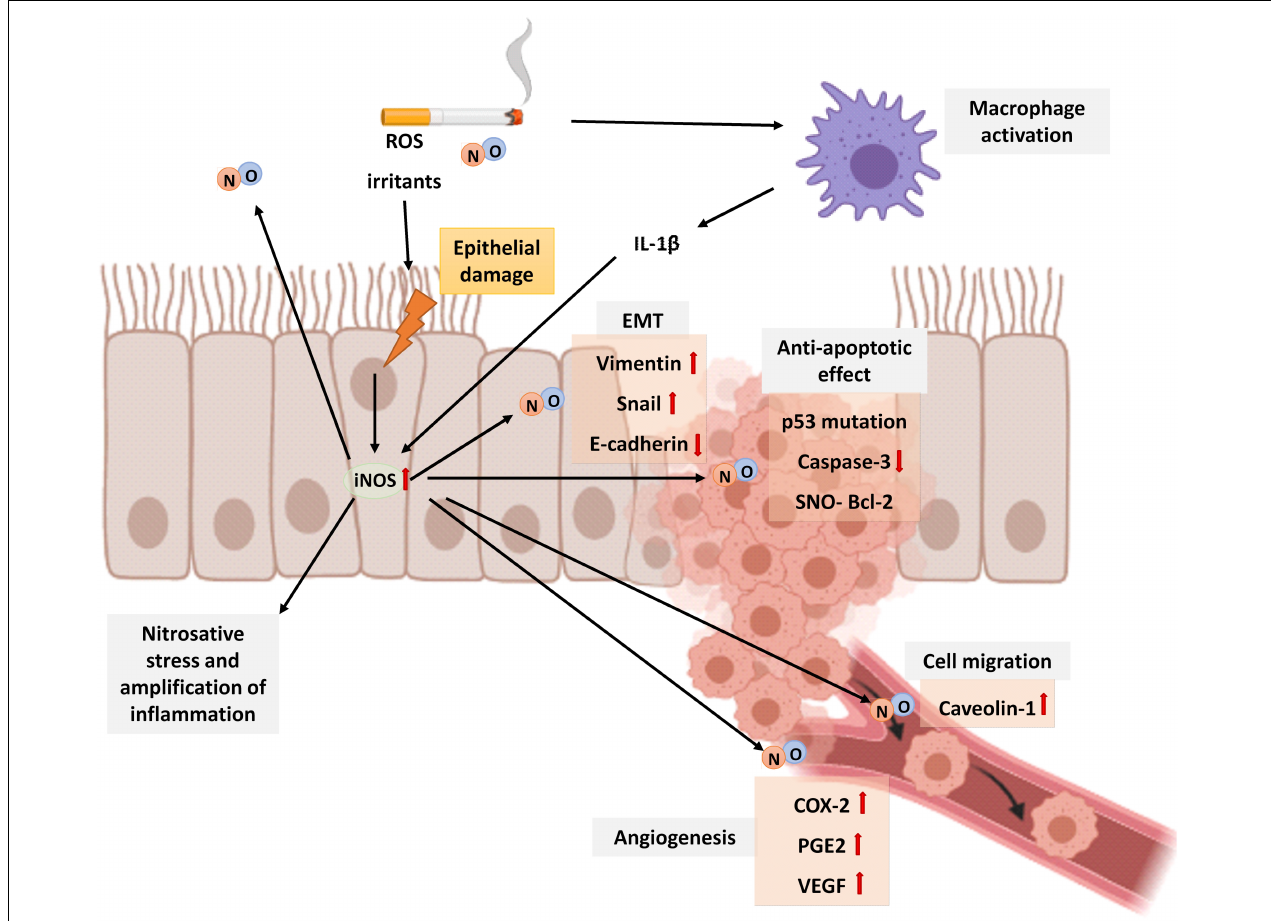
FIGURE 6 | Schematic representation of the role of NO in lung cancer. Cigarette smoke is a source of exogenous NO, irritants, and ROS that activates macrophages and epithelial cells of the airways to release cytokines that attract inflammatory cells to the lungs. In epithelial cells, the expression of the iNOS increases by proinflammatory stimuli such as IL-1 β produced by macrophages. Patients with lung cancer show higher levels of F E NO than healthy controls. An elevated NO generates nitrosative stress and amplification of inflammation. Although in physiological conditions, after DNA damage, NO activates p53 inducing apoptosis of cells, an excess of NO inactivates p53 function. In addition, higher concentrations of NO in the lung also downregulates caspase–3 activity and S-nitrosylation and stabilization of BCl-2 protein, all of them contributing to inhibition of apoptosis. Prolonged NO stimulation is additionally related to EMT by increasing vimentin and snail expression and decreasing E-cadherin levels. NO also enhances epithelial cell migration by caveolin-1 upregulation and angiogenesis by COX-2, PGE2, and VEGF upregulation. The image has been created with